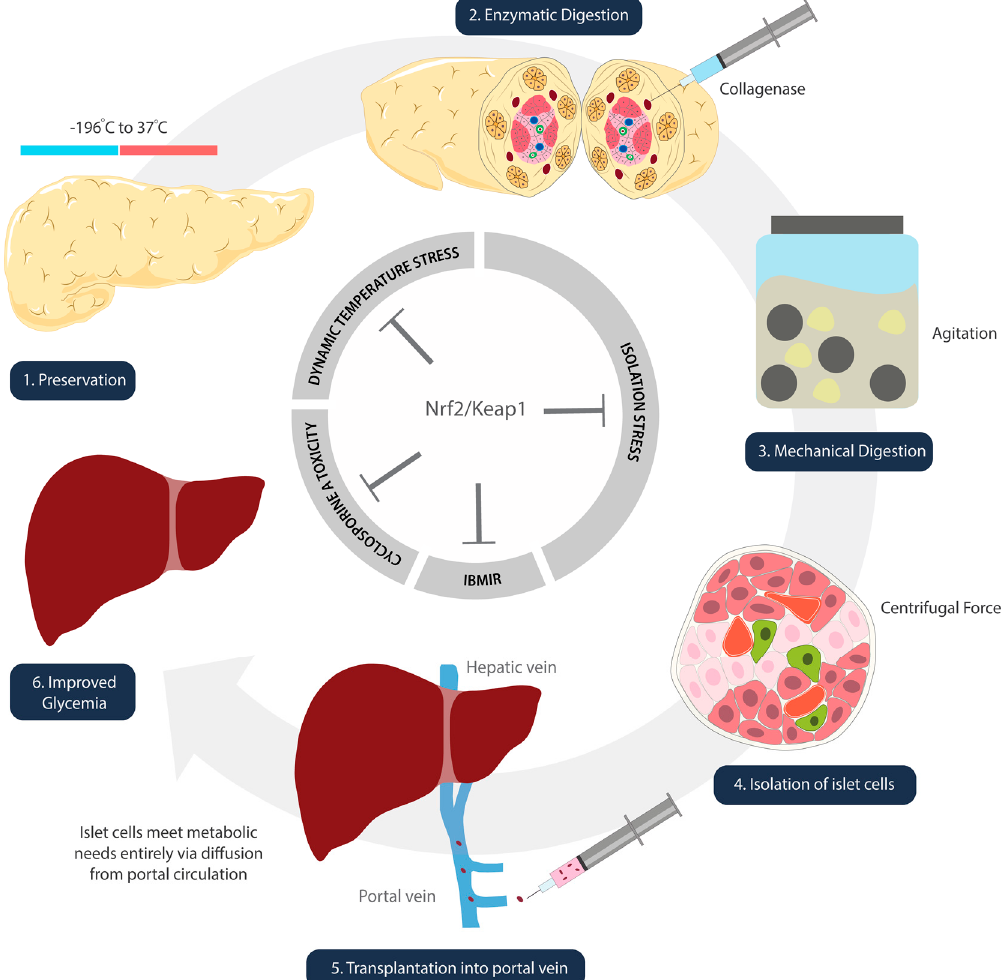
Figure 2. Schematic illustration denoting steps of islet cell transplantation. Nrf2/Keap1 pathway activation at each of these steps has the potential to ameliorate oxidative damage that occurs as a result of temperature (1), isolation (2–4), reperfusion (5), and immunosuppression side-effect- mediated